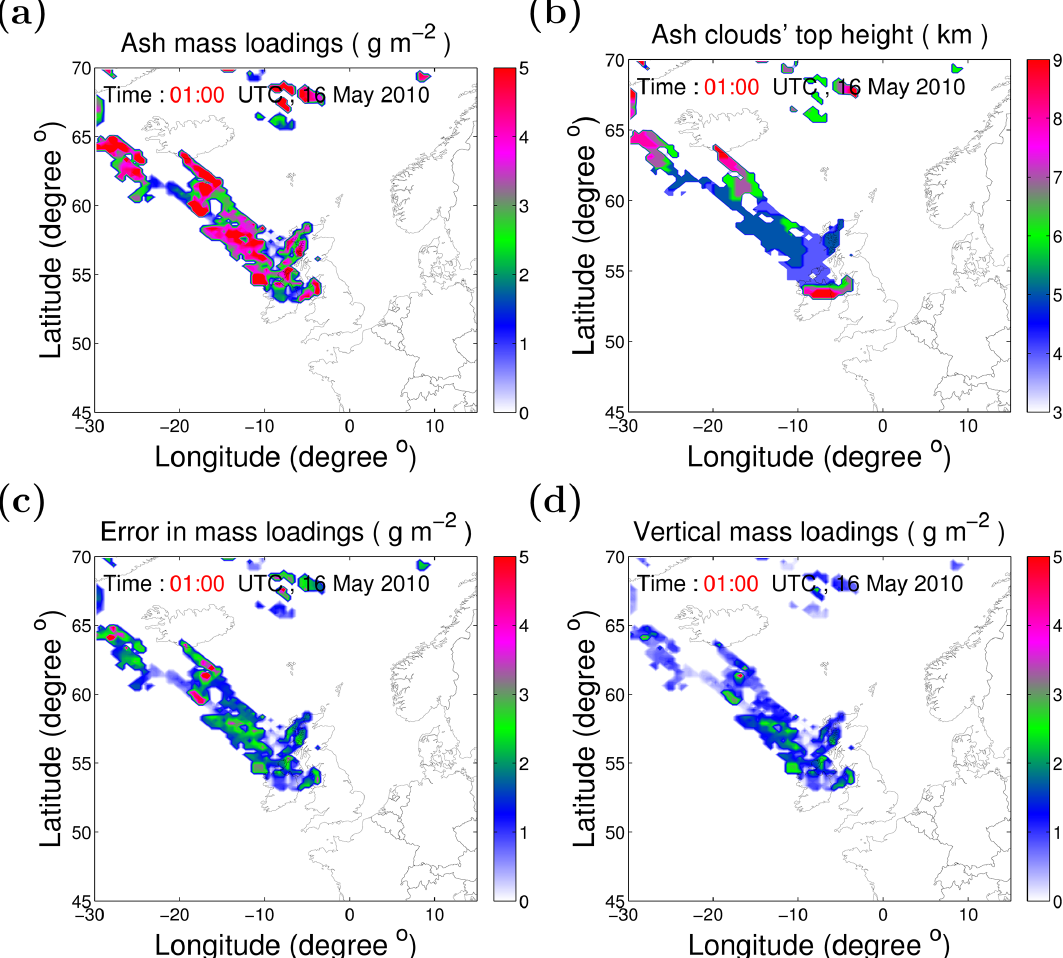
Figure 1. Available volcanic ash data from SEVIRI on 16 May 2010 at 01:00UTC. Data are acquired from the European Space Agency (ESA) funded projects Volcanic Ash Strategic Initiative Team (VAST). (a) Ash mass loadings. Values at 0 mean no data. (b) Ash cloud top height. (c) Error in the retrieved ash mass loadings (a) . (d) Ash mass loadings in the vertical direction, i.e., M v in Eq.